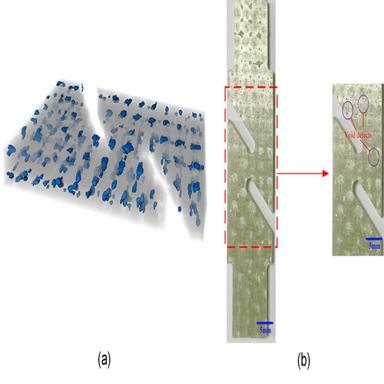
Mark of void defects: (a) Three views of segmentation image; (b) The distribution of defects existing on the sample.